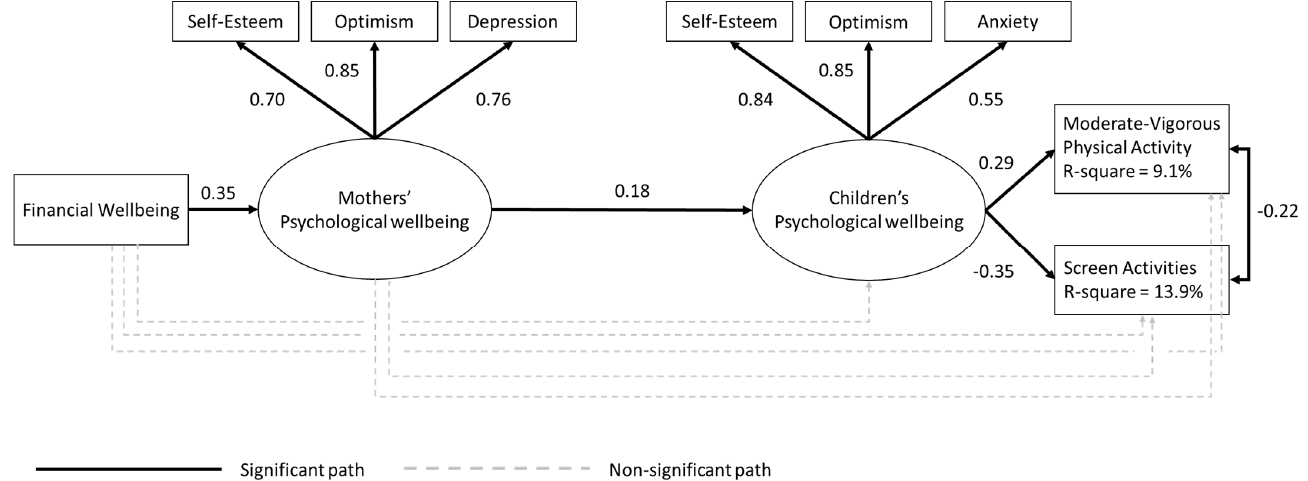
Figure 1. Financial wellbeing has an indirect effect on children’s health behaviors via mothers’ and children’s psychological wellbeing.